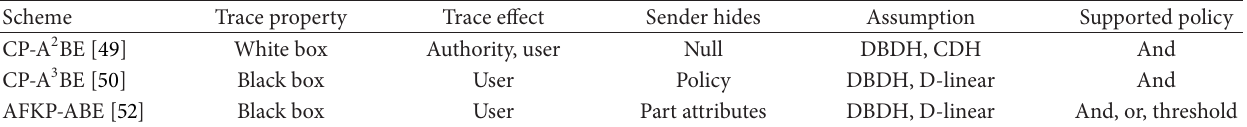
Table 6: Comparison of CP-A 2 BE, CP-A 3 BE, and